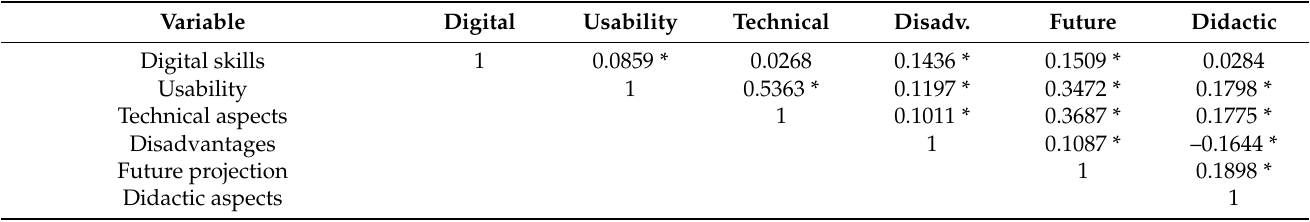
Table 3. Pearson correlation coefficients between the different families of